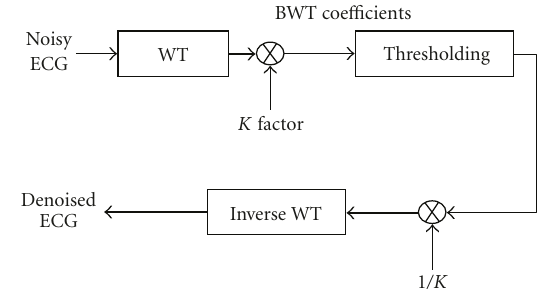
Figure 4: Block diagram of the bionic wavelet transform denoising